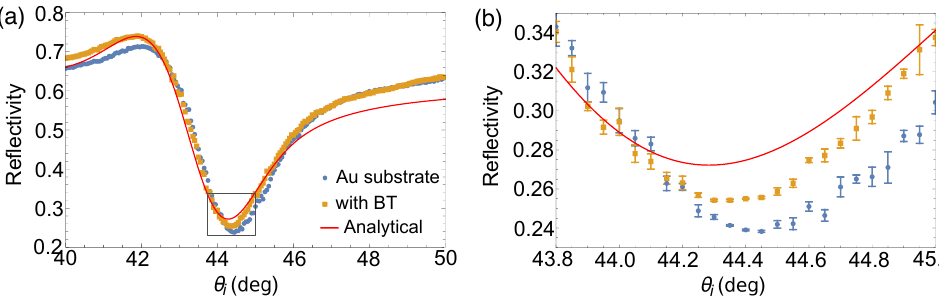
Figure 8. ( a ) Comparison of experimentally obtained reflectivity plots of bare Au substrate (blue circle); Au substrate coated with BT-SAM (yellow square) with analytical calculation (red solid line). ( b ) Closer inspection of boxed area in ( a ) over a smaller angular range to show the shift in θ SPR . Figure 9 shows the GH shift measurements of the bare Au substrate and with the presence of BT-SAM. Without any loss of generality, we took the linear regression within the vicinity of Γ = 0, before Γ reaches its maximum and minimum value, to determine a precise value of θ SPR . Trendlines are shown in Figure 9b, as well as their corresponding curve fitting equations. R 2 values indicate good linear correlation among chosen data points. We believe that linear regression within the vicinity of the SPR angle is a simplistic approach in determining the SPR angle. Our values are consistent with θ SPR obtained from reflectivity measurement. From the linear regression, we determined θ SPR = 44.43 ◦ for the bare Au substrate and θ SPR = 44.37 ◦ when BT-SAM is present. Error bars shown in Figures 8b and 9b correspond to the standard error of the mean obtained from measure- ments from four different substrates used in each sample set. Small error bars indicate repeatable measurements for samples from the same fabrication batch.